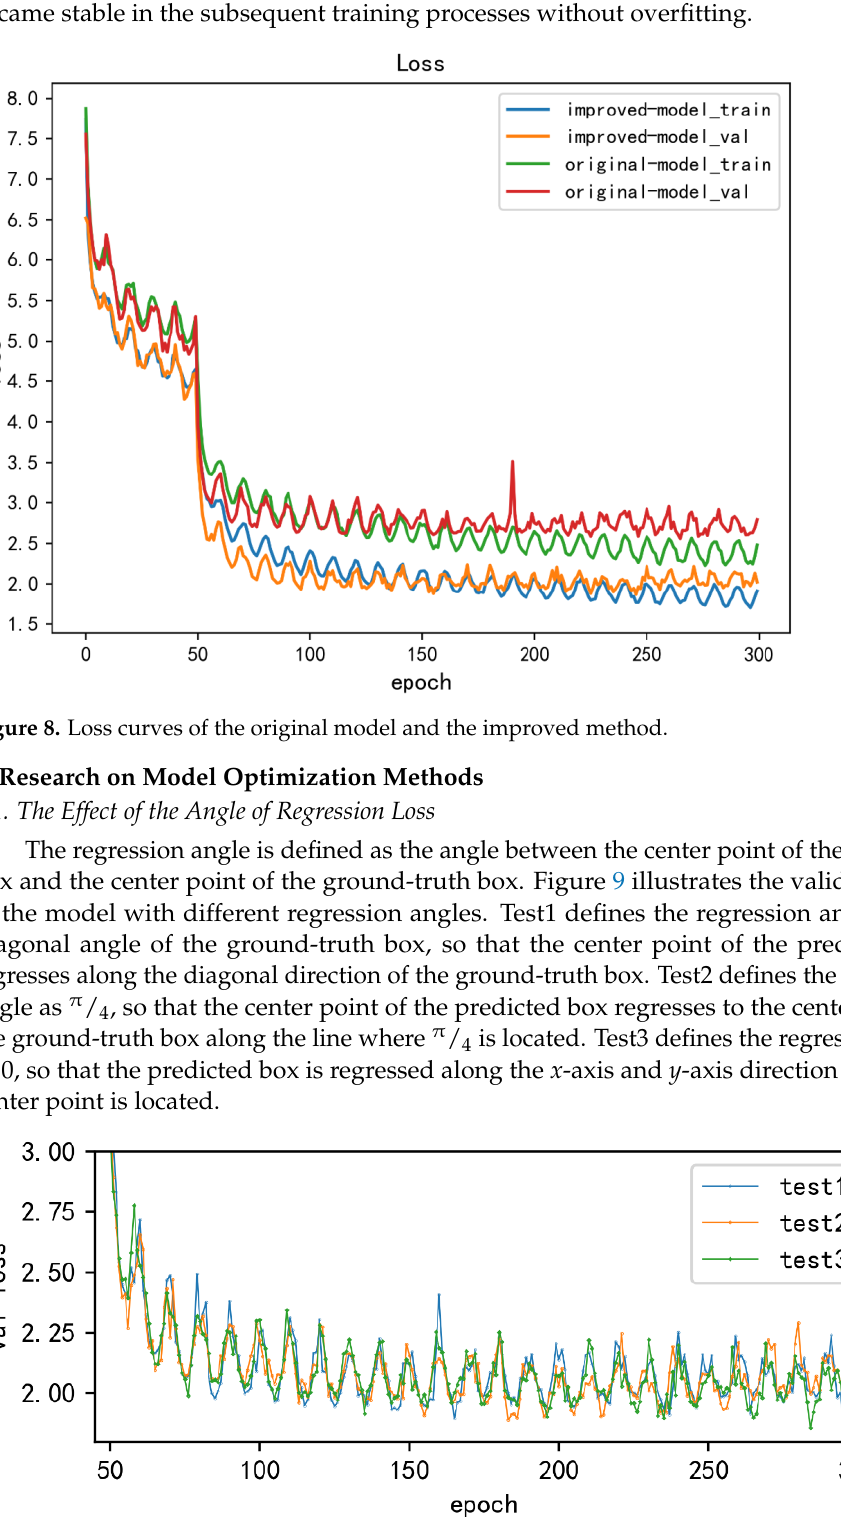
Figure 9. Validation loss of training with different regression angles.